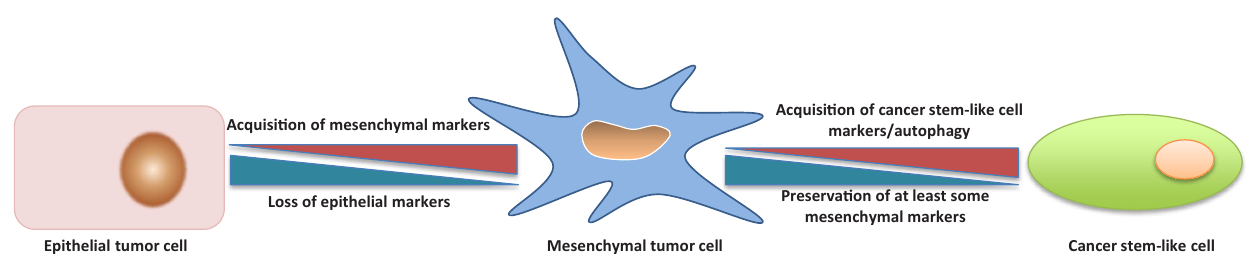
FiGURe 1 | Transition from a Tumor Cell with a Predominantly epithelial Phenotype to a Tumor Cell with a Predominantly Mesenchymal Phenotype and to a Cancer Stem-Like Cell (CSC) . The transition from a predominantly epithelial to a predominantly mesenchymal phenotype is better understood in molecular and phenotypic terms, but most available data suggest that a tumor cell with a predominantly mesenchymal phenotype must undergo several changes in order to acquire properties of a CSC, including autophagy. The heterogeneity of CSC populations suggests also the possibility of different transition states between a predominantly mesenchymal tumor cell and a CSC, in analogy with what has been observed for the transition between predominantly epithelial and mesenchymal tumor cells. See text for discussion and references to this